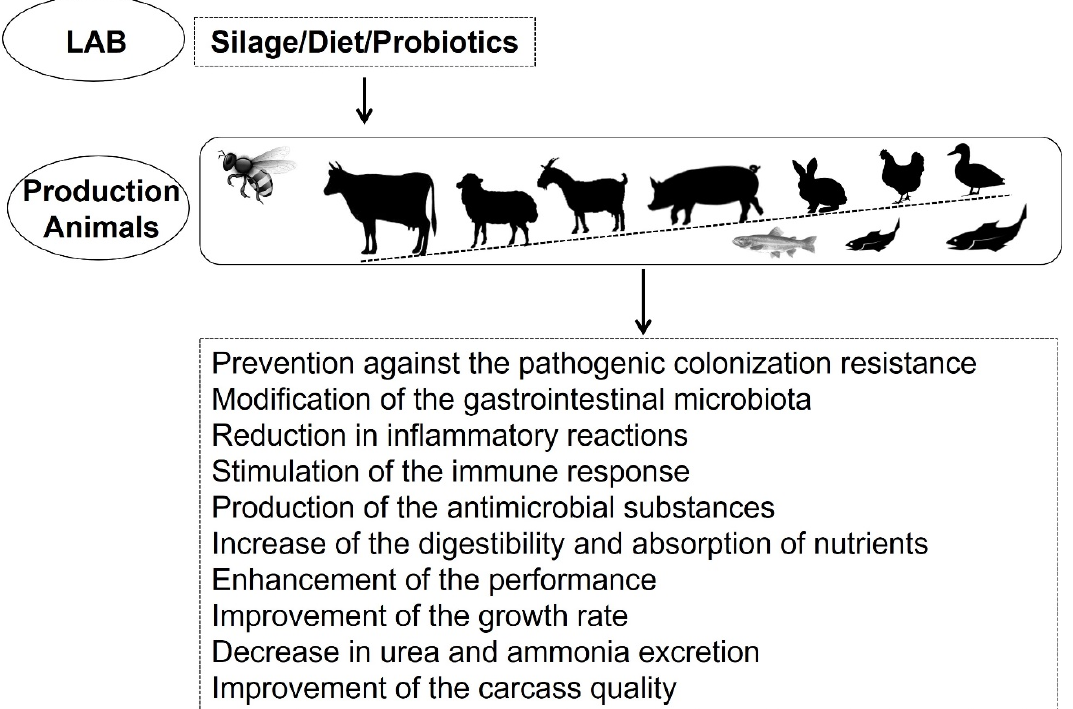
Figure 1. Main advantages of application of lactic acid bacteria (LAB) in animal production.